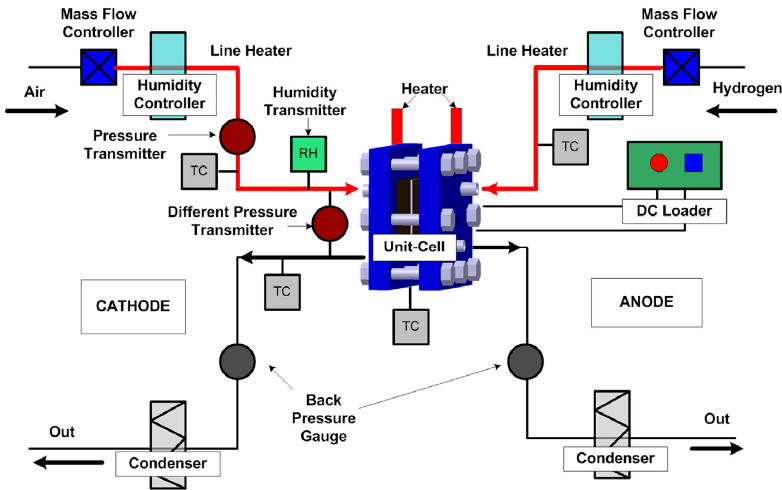
Figure 4. Systematic of a wave form channel.